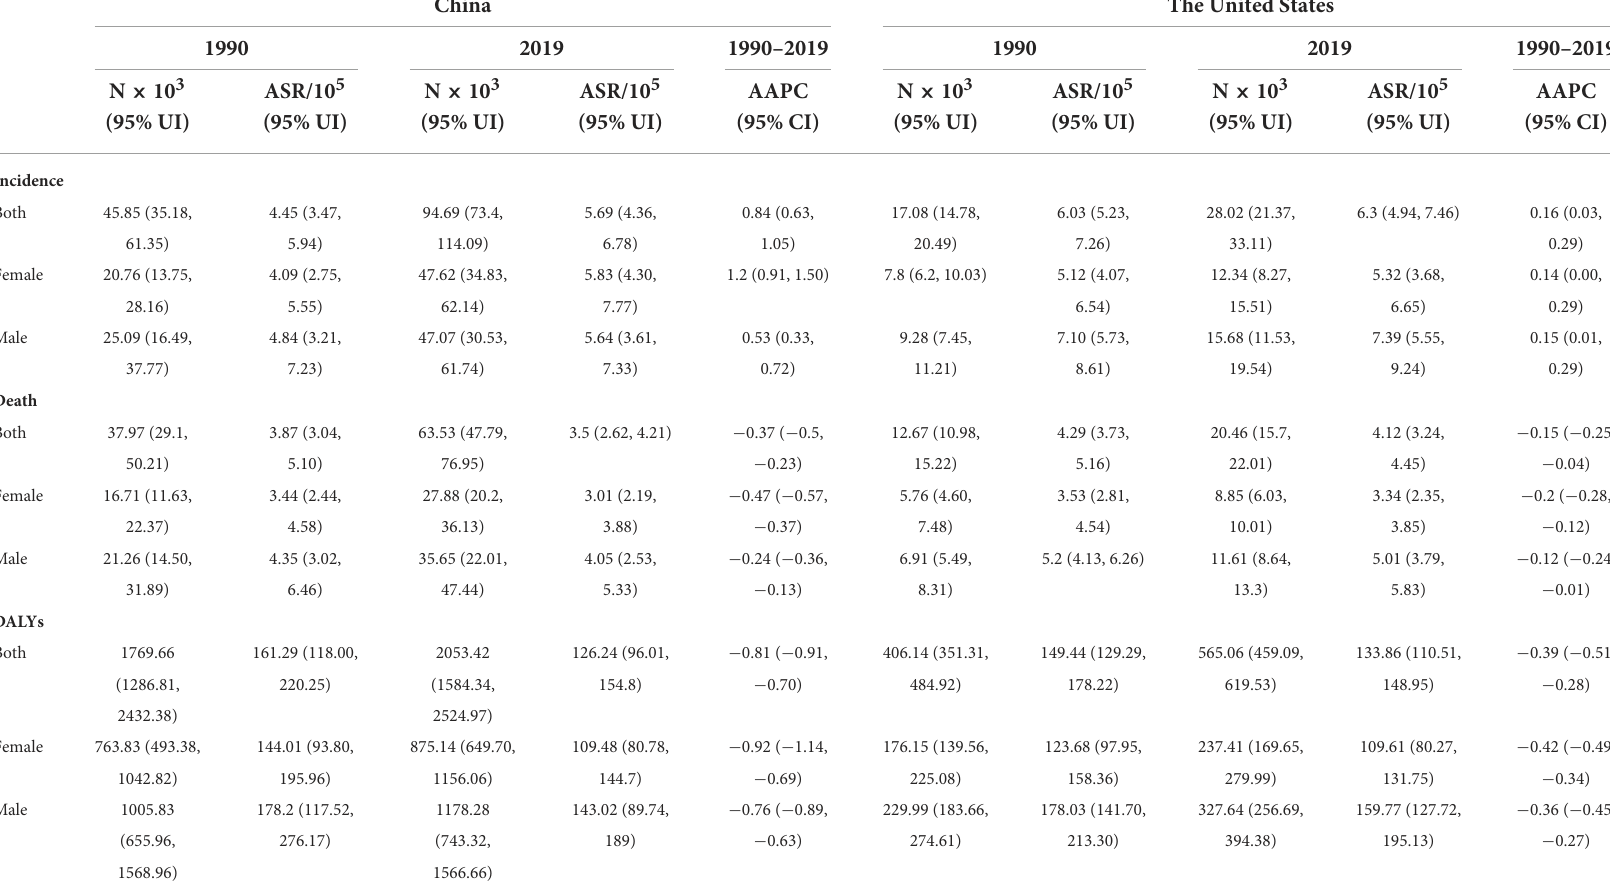
TABLE 1 The number and the age-standardized rates of incidence, deaths, and DALYs for brain and CNS cancers in China and the US and the average annual percentage change from 1990 to 2019.